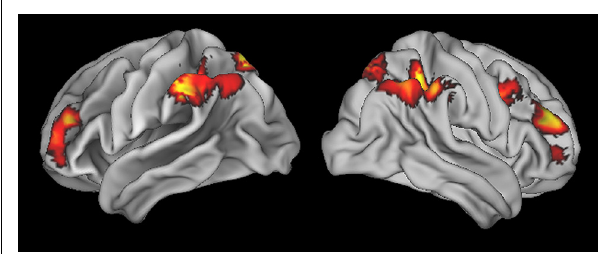
FIGURE 2 | Regions of activation for all quantifier conditions relative to precise number